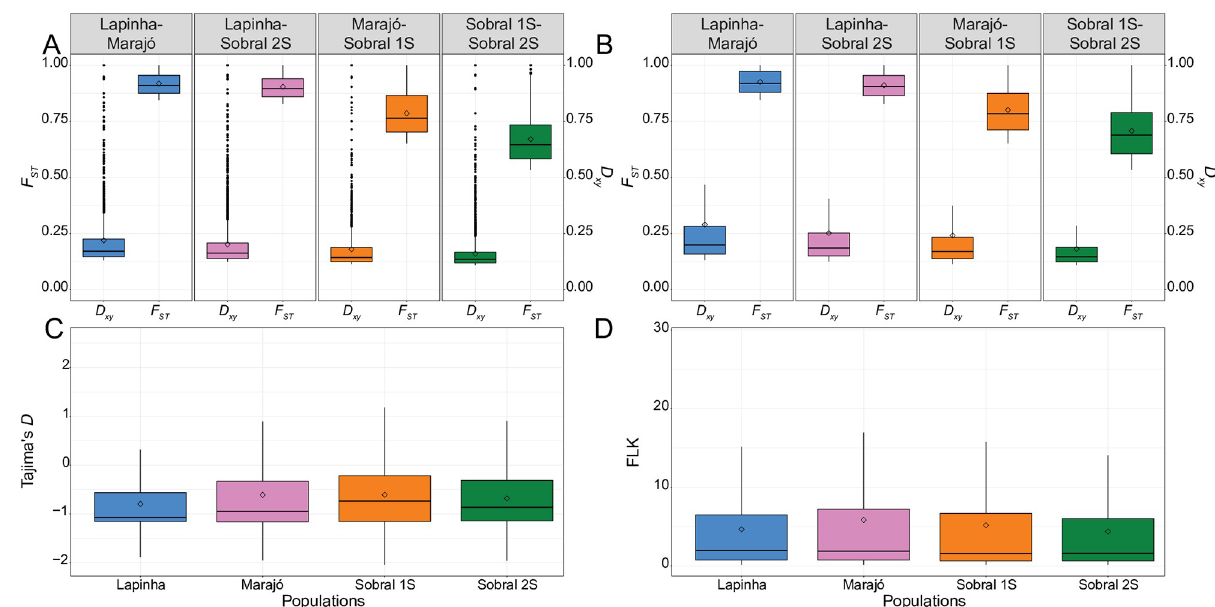
and F values for windows xy ST